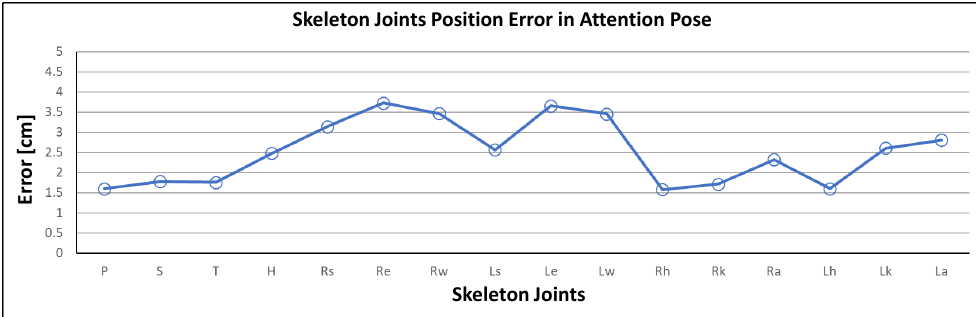
Figure 7. Skeleton reconstruction accuracy from lidar data against ground truth in attention